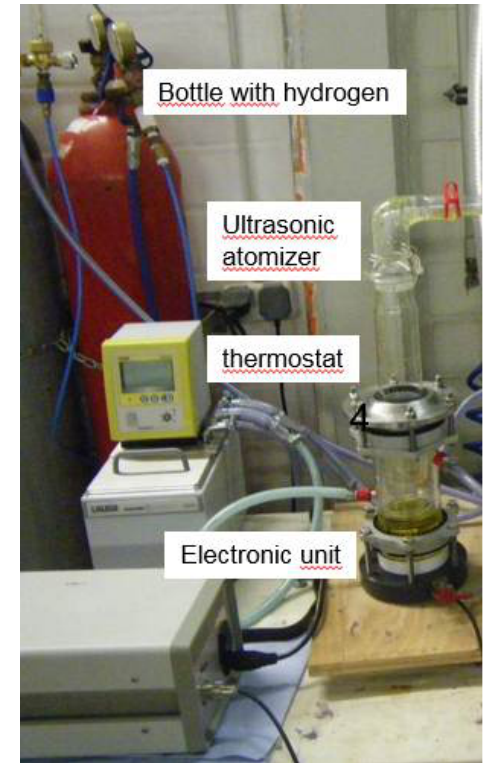
Figure 1 – One step USP lab-scale horizontal